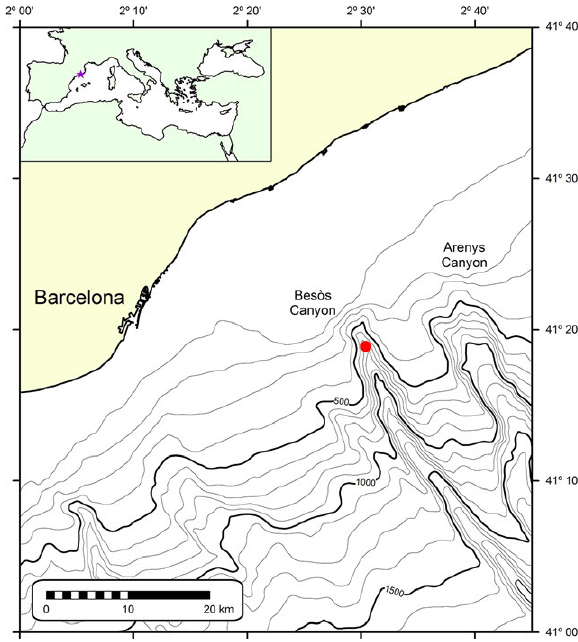
Fig. 1. – Bathymetric chart of the northwestern Mediterranean continental margin showing the location of the Besòs Canyon. The red dot indicates the site where the Aqualog profiler was deployed (2.52 ° E, 41.31 °